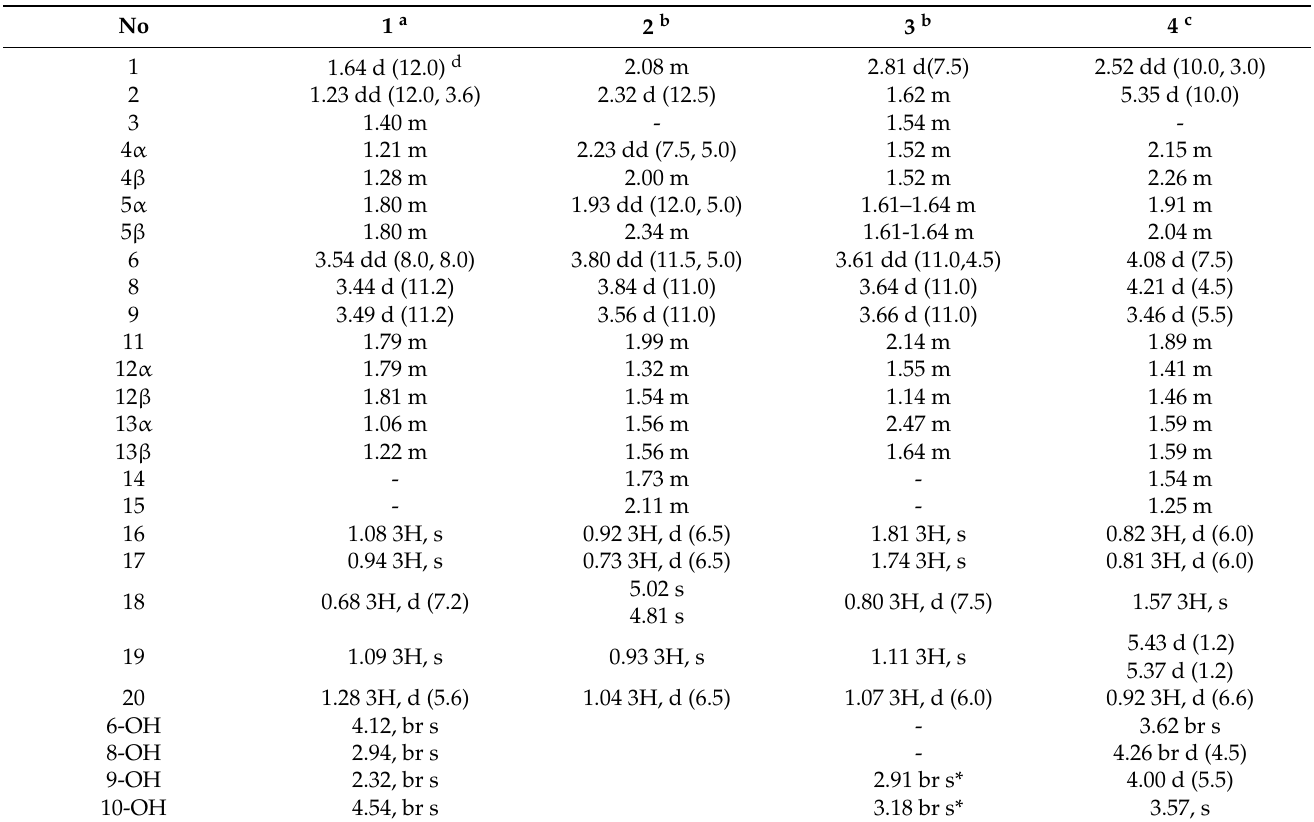
Table 2. 1 H NMR spectroscopic data of compounds